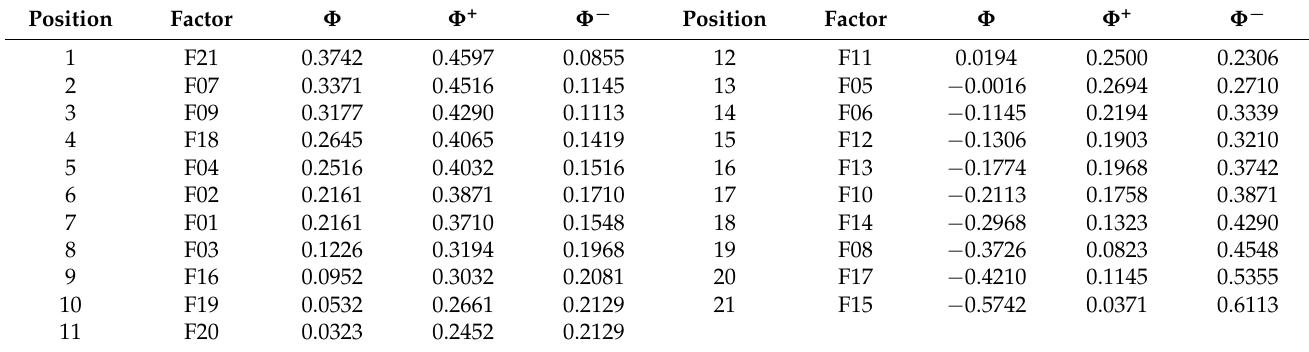
Table 2. Ranking of key factors from the judgment of the respondent